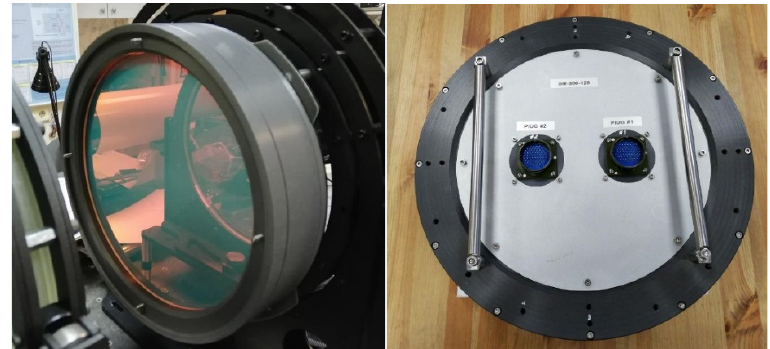
Figure 3. Photos of the front and back views of DM.